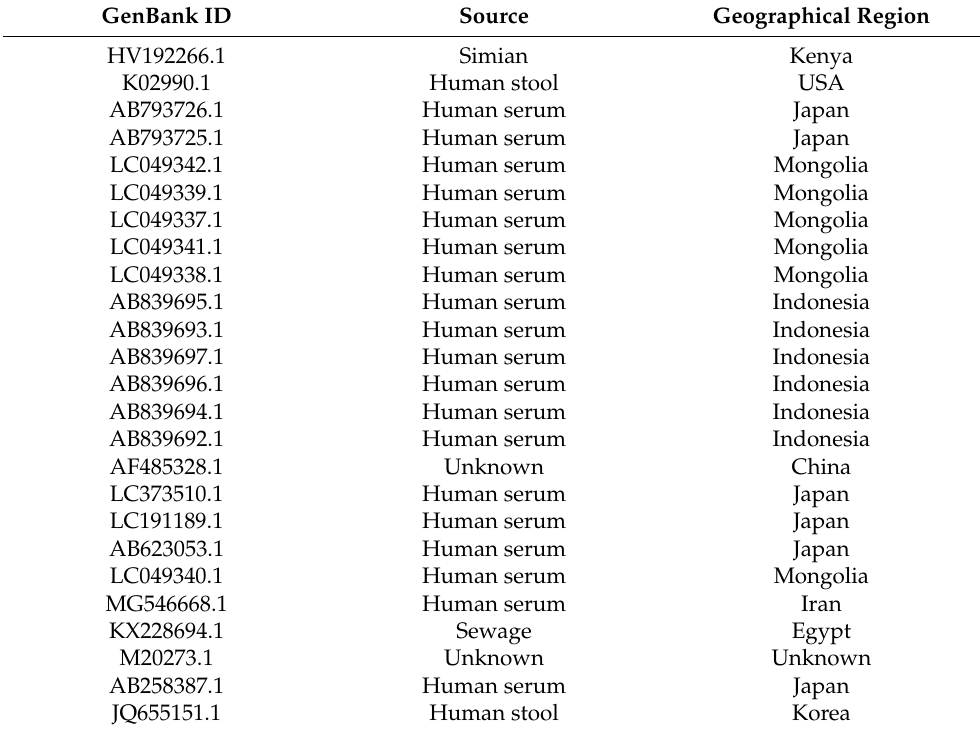
Table 1. Hepatitis A genome sequences from NCBI.